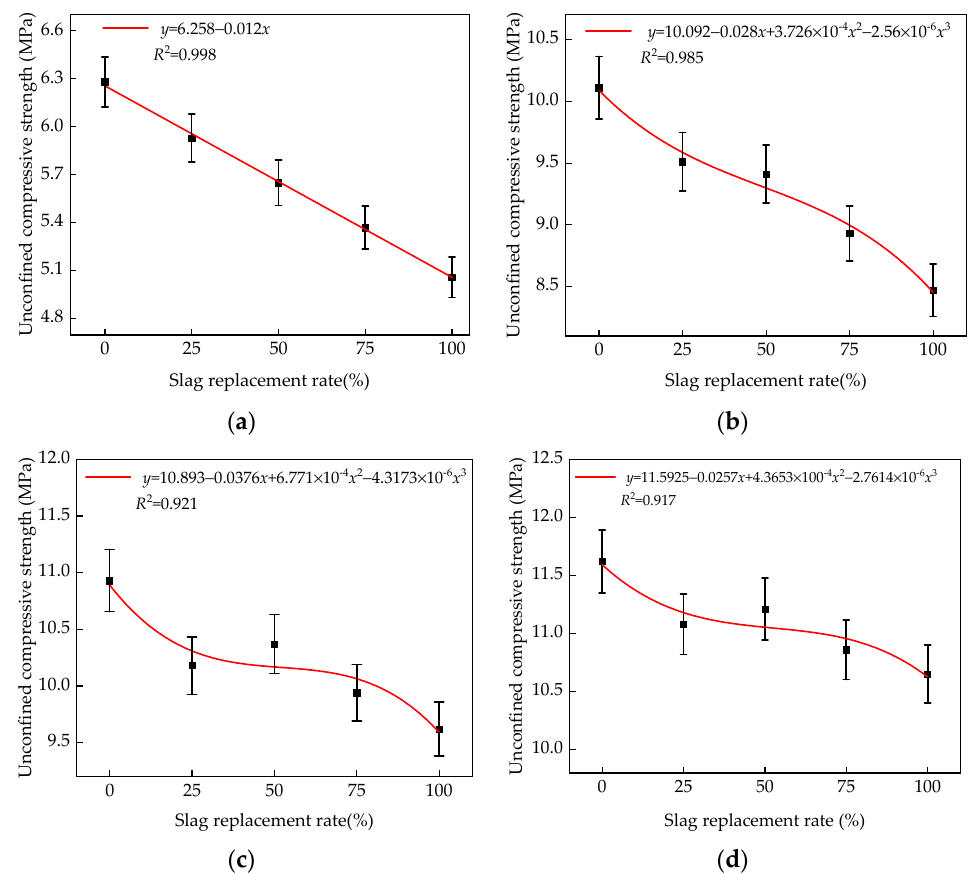
Figure 8. Fitting formulas of unconfined compressive strength with various slag replacement rates and ages: ( a ) 7 days; ( b ) 28 days; ( c ) 56 days; ( d ) 90 days.